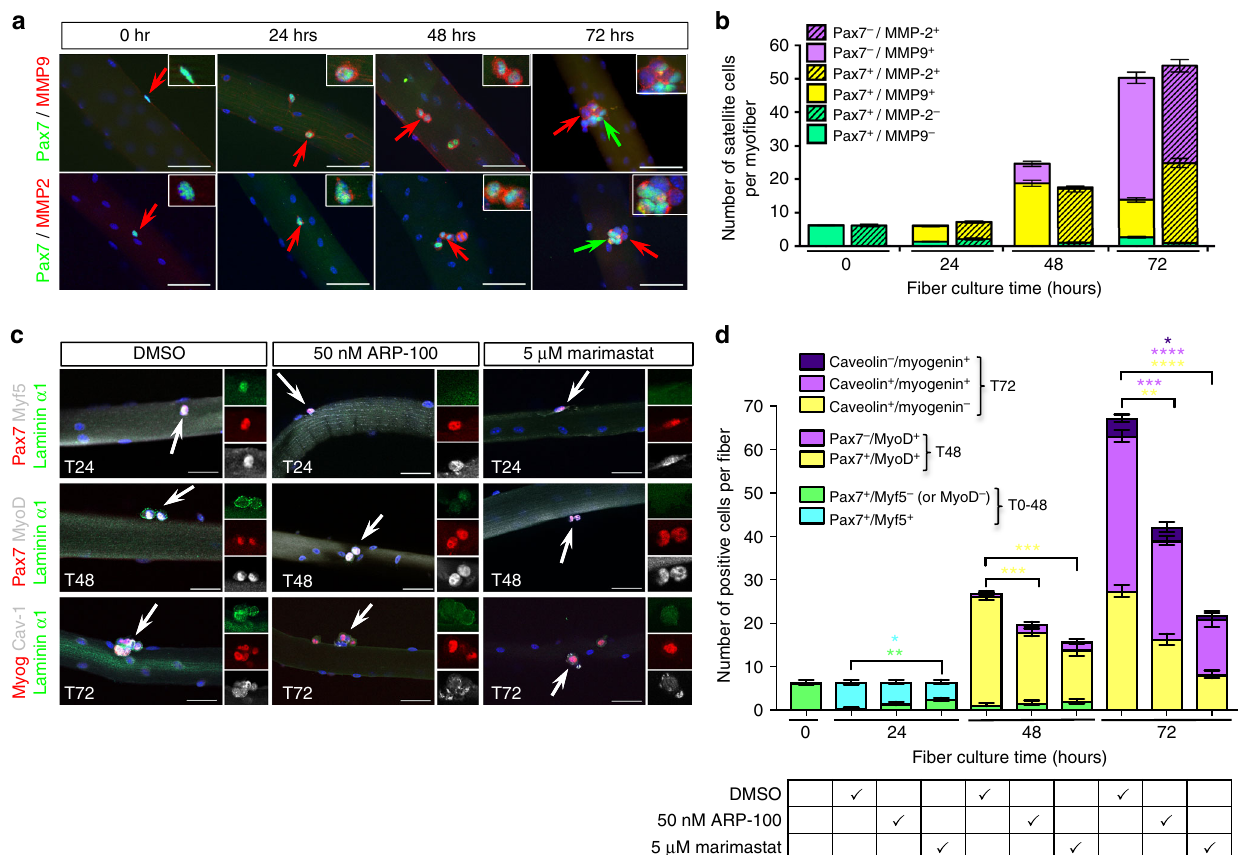
Fig. 3 MMP2 and MMP9 catalyze SC basal lamina remodeling. a Immuno-localization of MMP2 and MMP9 (red) in EDL myo fi bers cultured for 72 h. Inserts are high magni fi cation of satellite cells indicated by red arrows. Green arrows indicate Pax7 + satellite cells that are likely to be self-renewing cells and are negative for MMP2 and MMP9. Scale bar, 50 μ m. b Quanti fi cation of the number of SCs expressing MMP2 and MMP9 in cultured EDL myo fi bers. The color code used relates to the cell populations described in Fig. 1b. n = 5 experiments with 50 myo fi bers per time point. c Representative images of control (DMSO) or treated myo fi bers cultured in the presence of the MMP inhibitors ARP-100 and Marimastat. Arrows indicate SCs shown at high magni fi cation in inserts. Note the reduced deposition of laminin α 1 after 24 h and 48 h in the presence of ARP-100 and the complete absence of laminin α 1 after 24 h and 48 h in the presence of Marimastat. Scale bar, 50 μ m. d Quanti fi cation of the effect of MMP inhibition by ARP-100 and Marismastat on the progression of SCs through the myogenic program in the ex-vivo myo fi ber culture system. n = 3 experiments with 25 – 40 fi bers per time point. Graphs show mean + sem. * P < 0.05, ** P < 0.01, *** P < 0.001, **** P < 0.0001 ( t + MyoD + ) cells (Fig. 4b – d). Laminin- α 5 was not upregulated in